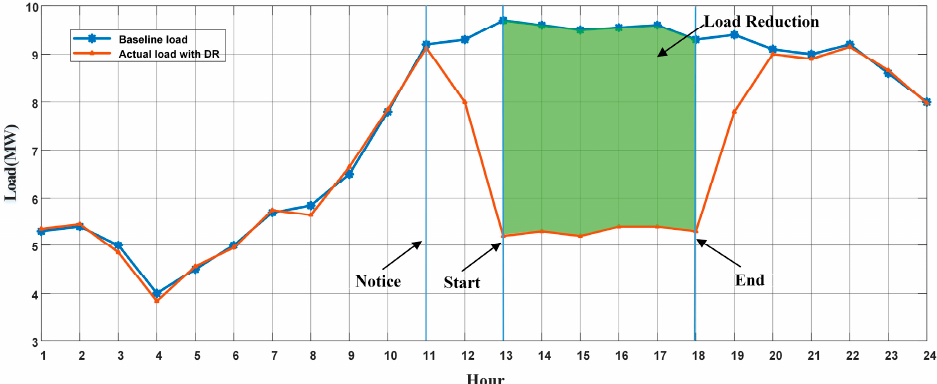
Figure 1. Relationship among predicted customer baseline load (CBL), actual load, and load reduction.